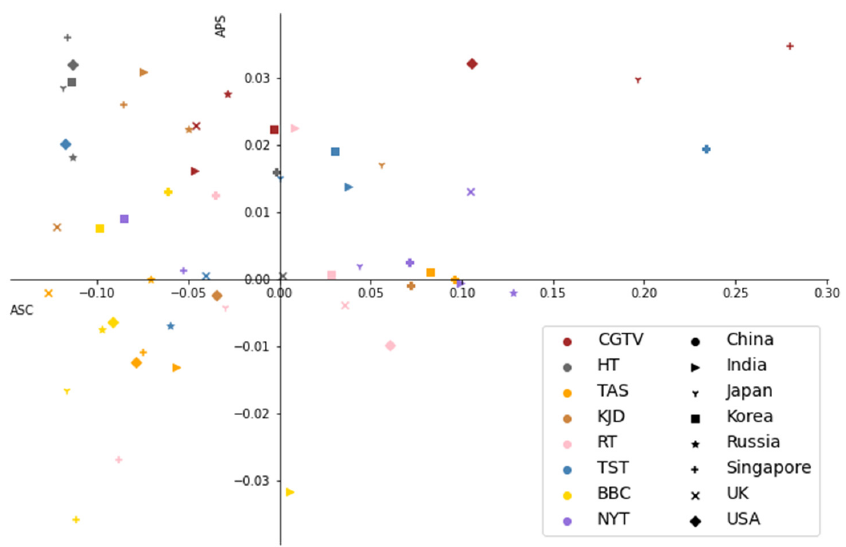
Figure 7. The ACS and APS of international news agencies.